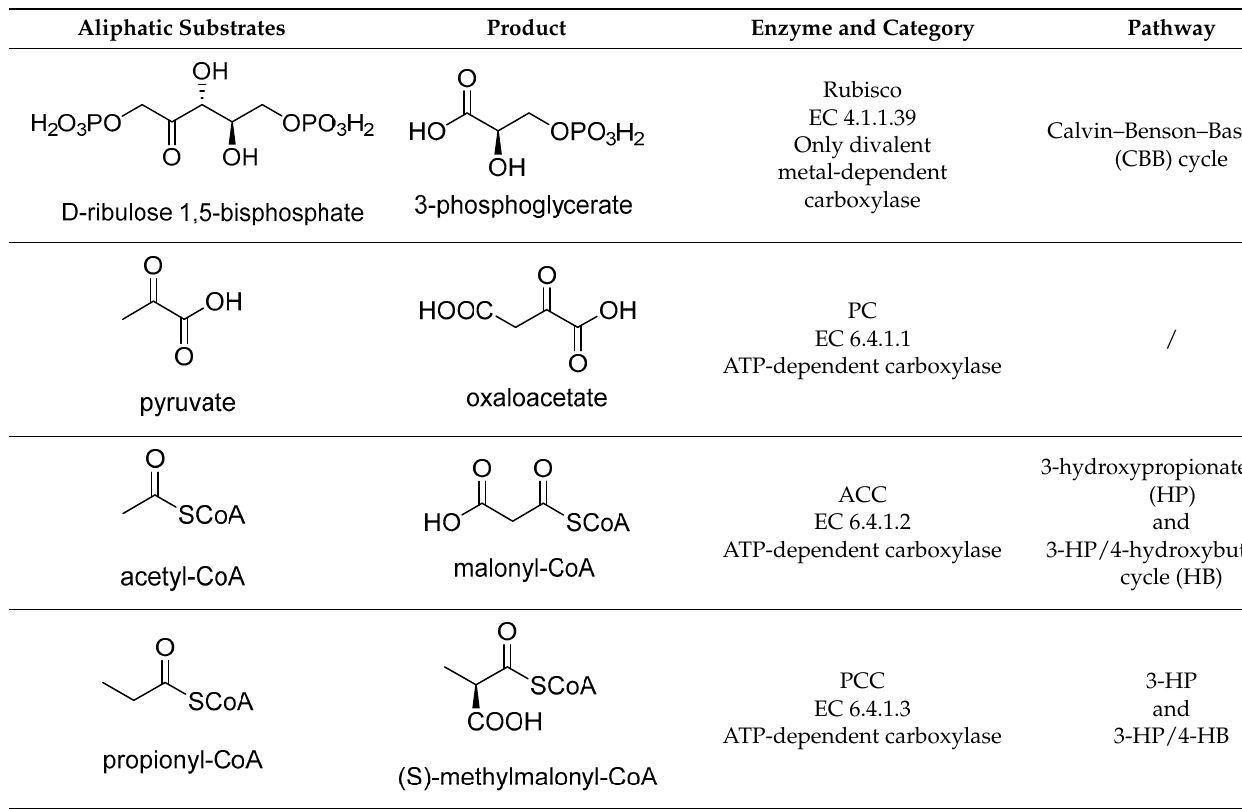
Table 1. Representative carboxylases for CO 2 fixation.